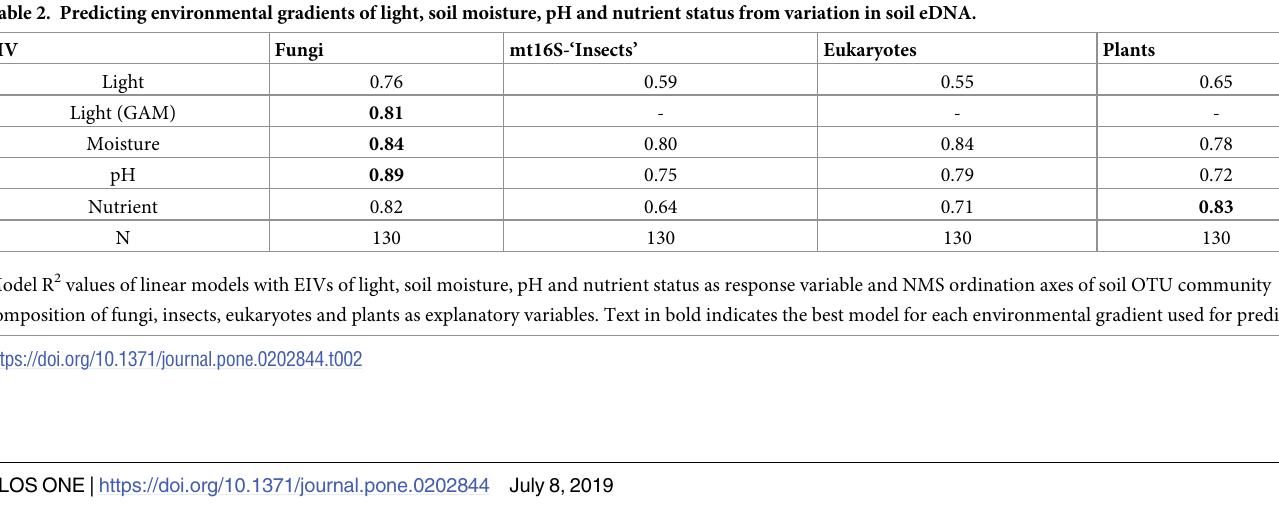
Table 2. Predicting environmental gradients of light, soil moisture, pH and nutrient status from variation in soil eDNA. EIV